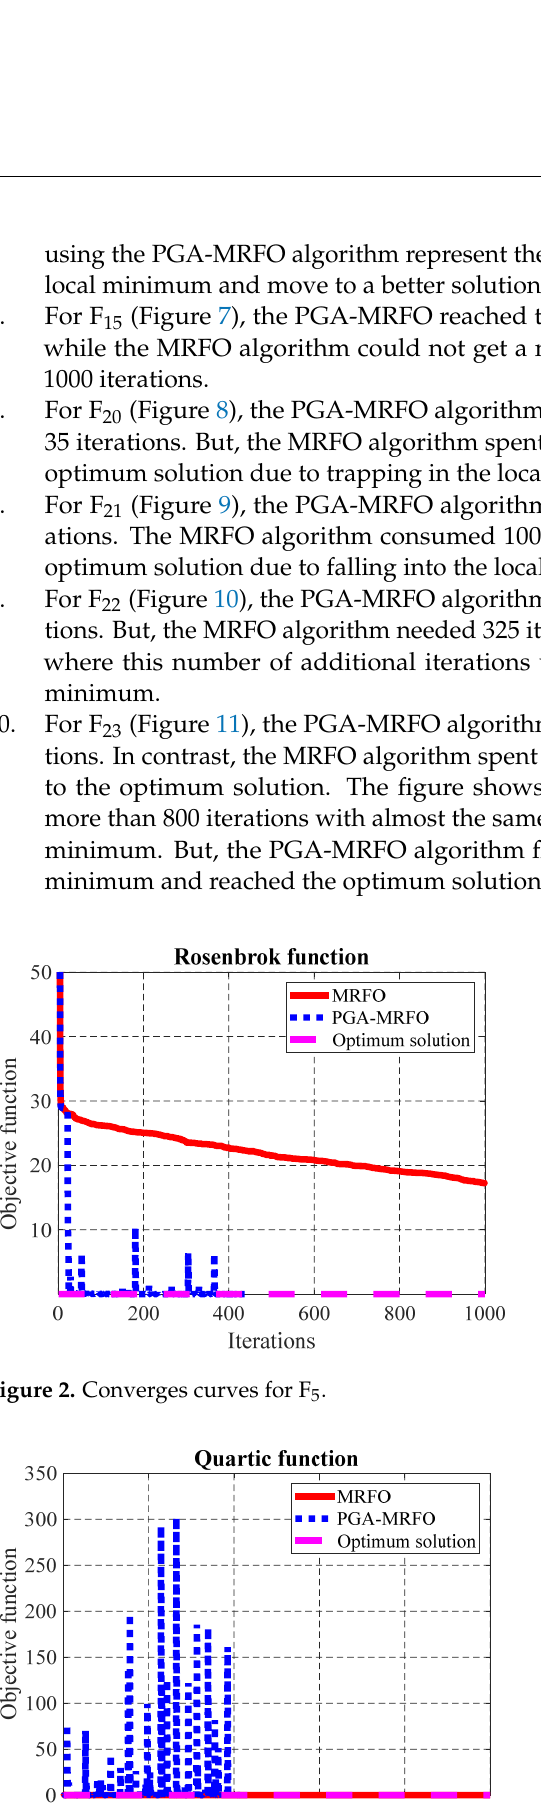
Figure 3. Converges curves for F 7 .